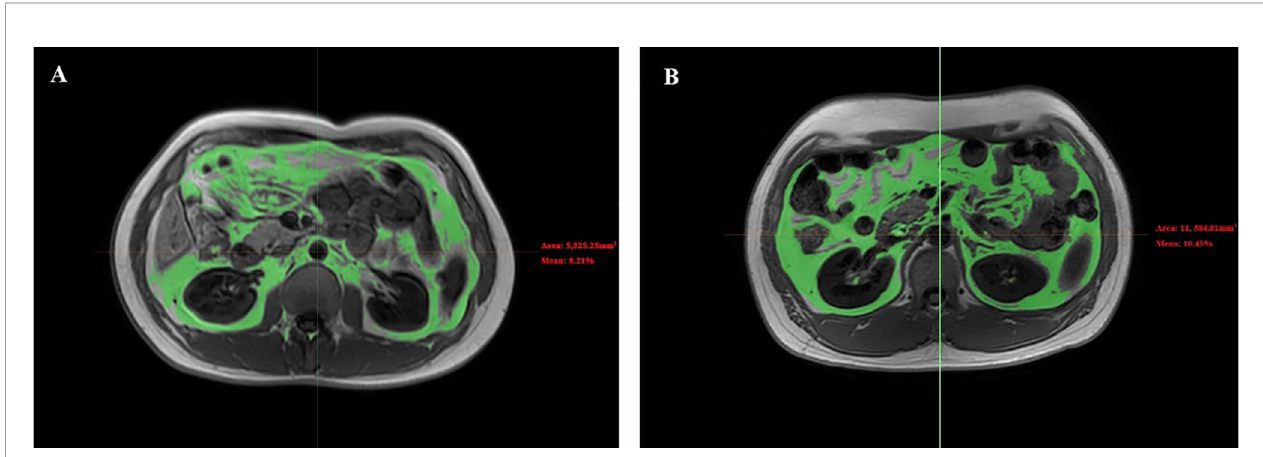
FIGURE 1 | Representative abdomen MRI images of VAT between diabetes group and control group. Representative abdomen MRI images in a healthy volunteer (A) and a patient with diabetes (B) . Results for the percentage of the VAT were 8.21% for the healthy volunteer and 10.45% for the patient with diabetes. VAT, visceral